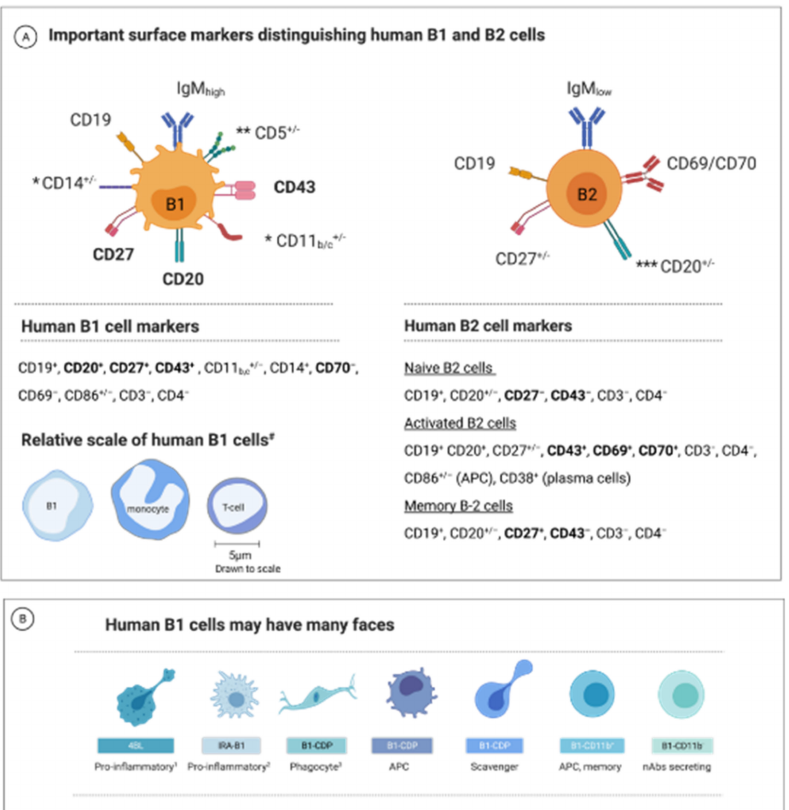
Figure 1. Currently proposed human B1 cell markers. ( A ) The human B1 lymphocyte population exhibits phenotypical, morphological, and functional diversity. The primary surface markers of